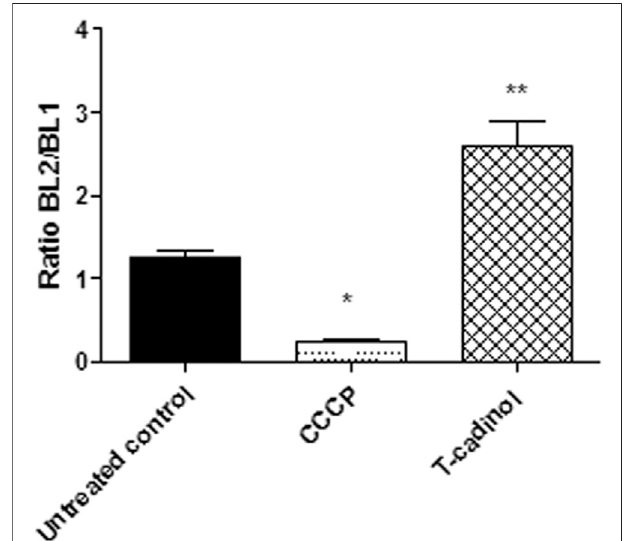
FIGURE5|- Evaluationofmitochondrialmembranepotential( Δ ψ m )in T. cruzi trypomastigotes treated with compound 1 (T-cadinol − 18.2 μ M) for 4 h. JC-1 dye fl uorescence was monitored by fl ow cytometry (excitation 488 nm and emission 530/574 nm). Untreated trypomastigotes and those treated with CCCP (100 μ M) were used to achieve minimal and maximal